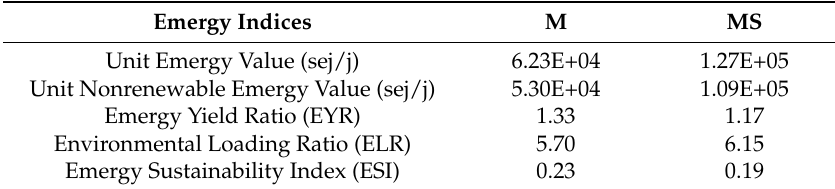
Table 5. Emergy indicators of the cropping